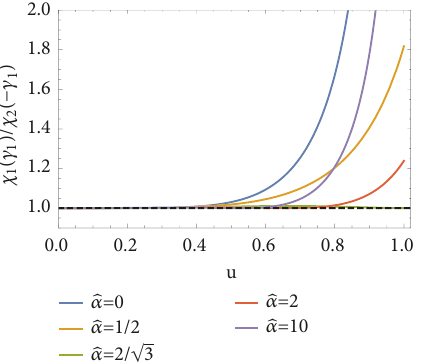
Figure3: X 1 (𝛾 1 )/ X 2 (−𝛾 1 ) asthefunctionof 𝑢 withdifferent ̂𝛼 .Here we set 𝛾 1 = 0.02